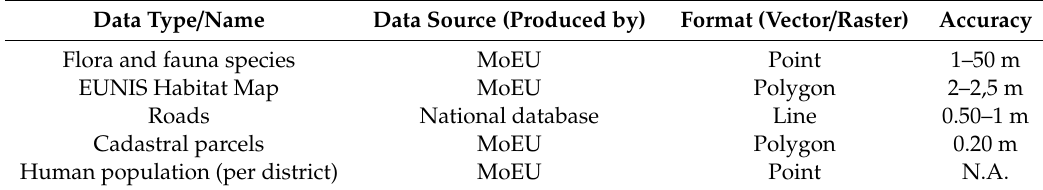
Table 3. Formats, sources, and accuracies of the datasets evaluated in the study.